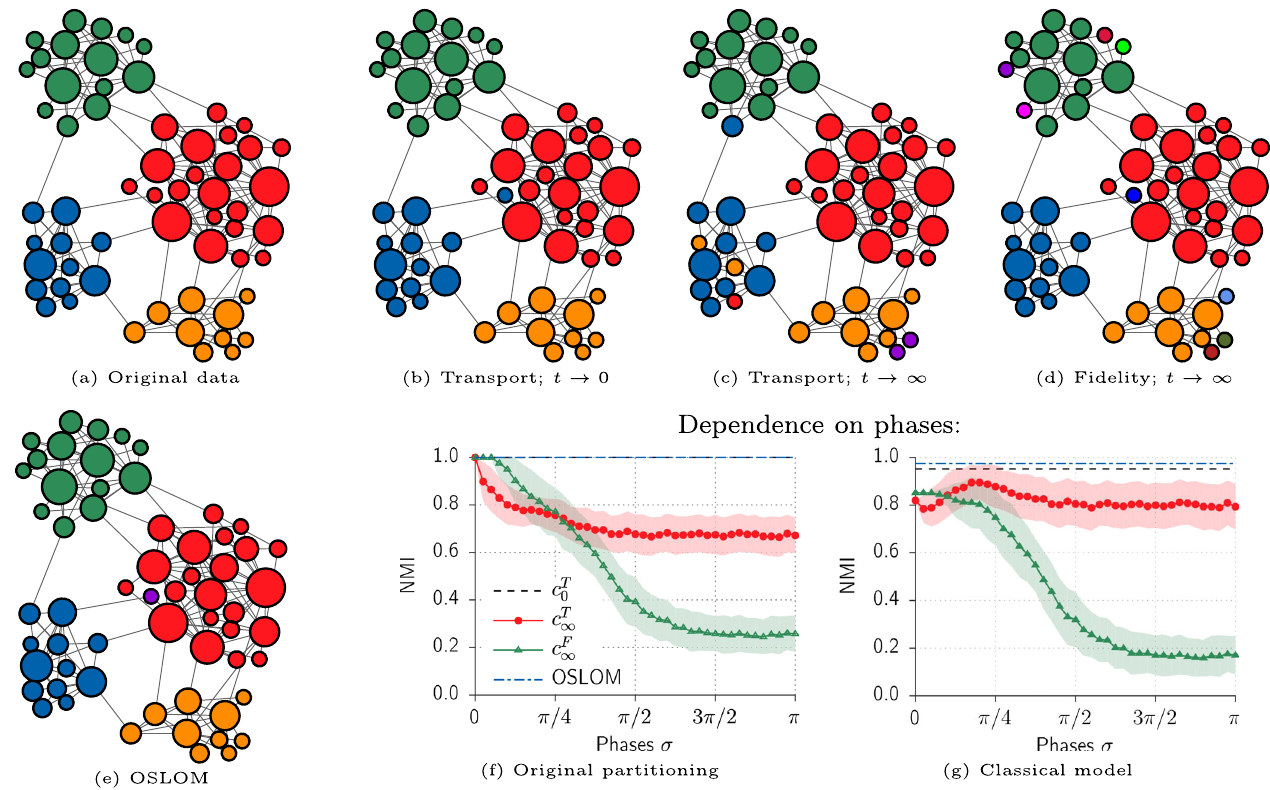
FIG. 3. Artificial community structure. (a) Classical community structure used in creating the network. (b) – (e) Community partitionings found using the three quantum methods and OSLOM . (f),(g) Behavior of the approaches as the phases of the Hamiltonian elements are randomly sampled from a Gaussian distribution of width σ . The mean NMI, compared with zero phase partitioning (f) and the classical model data (g), over 200 samplings of the phase distribution is plotted. The standard deviation is indicated by the shading. Both OSLOM and c T 0 are insensitive to phases and thus do not respond to the changes in the